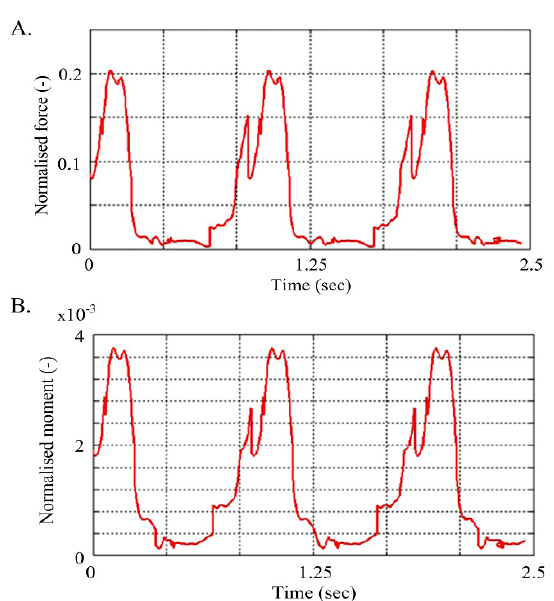
Figure 9. A. The diagram of normalized muscle force; B. The diagram of normalized muscle moment of the musculus gastrocnemius medialis of children with cerebral